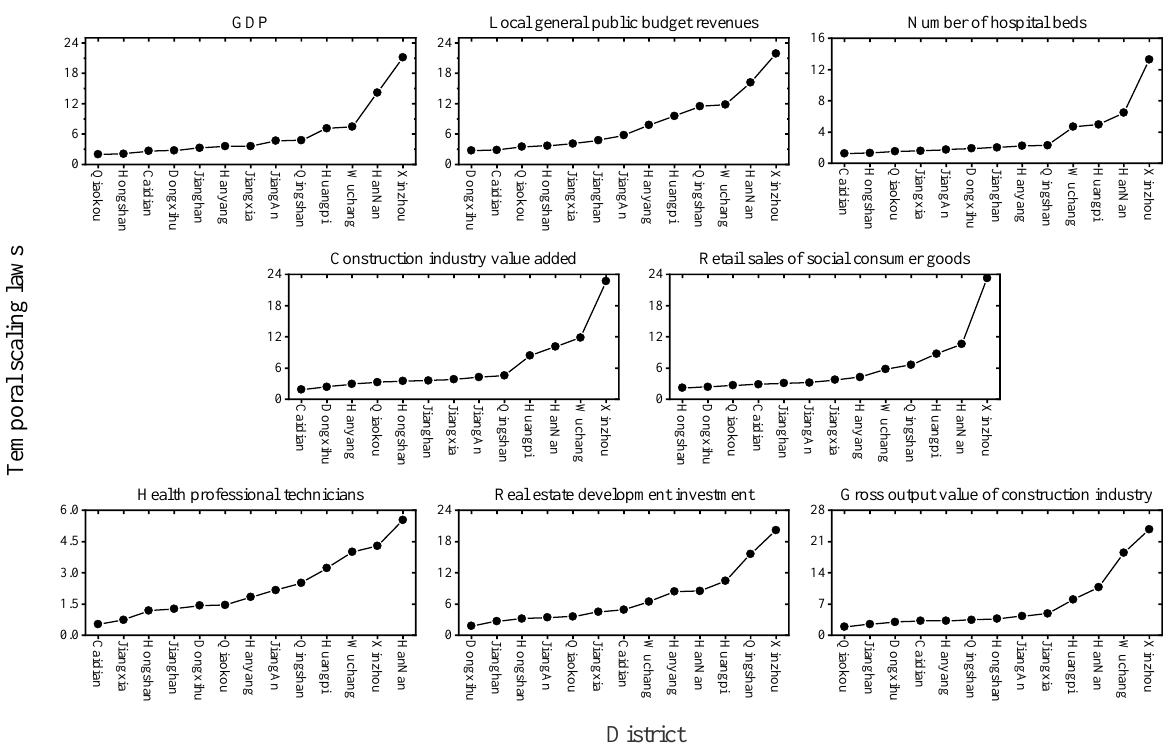
Figure 5. Temporal scaling law of each region.